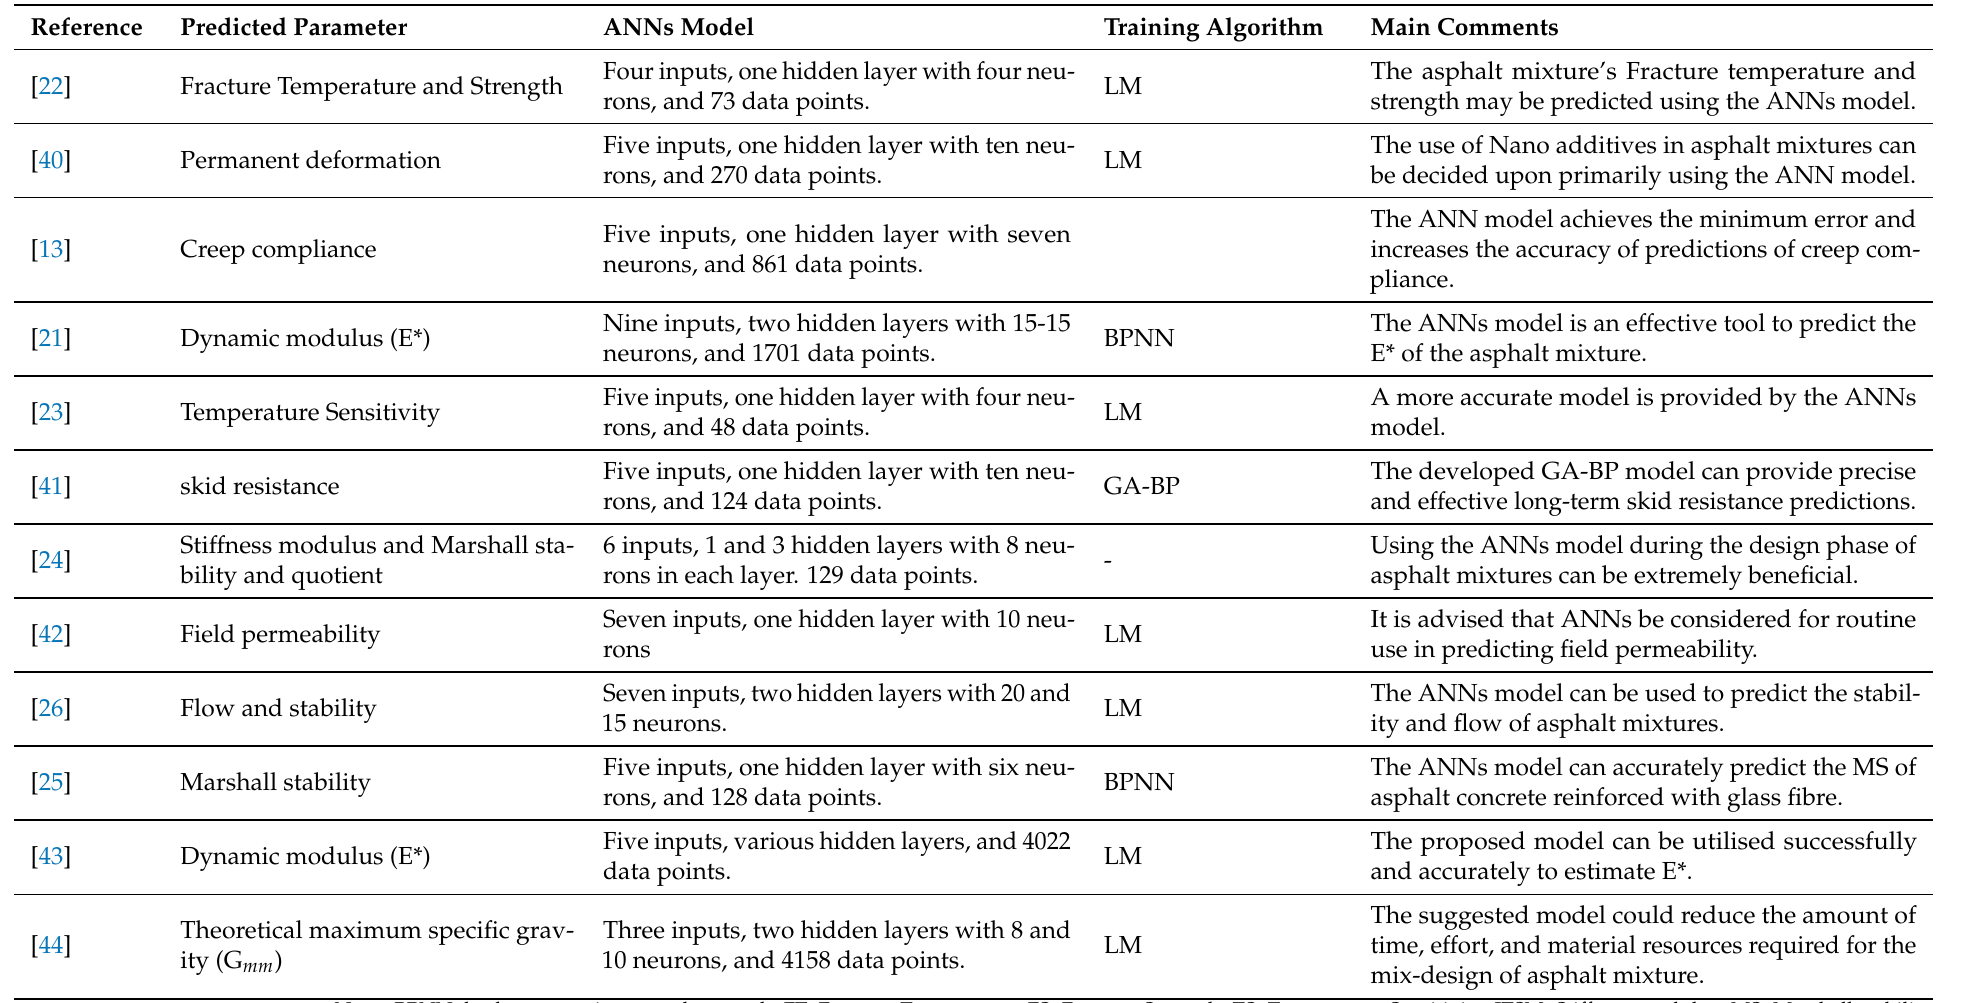
Table 1. Predicting the rheological and performance properties of asphalt mixtures using ANNs